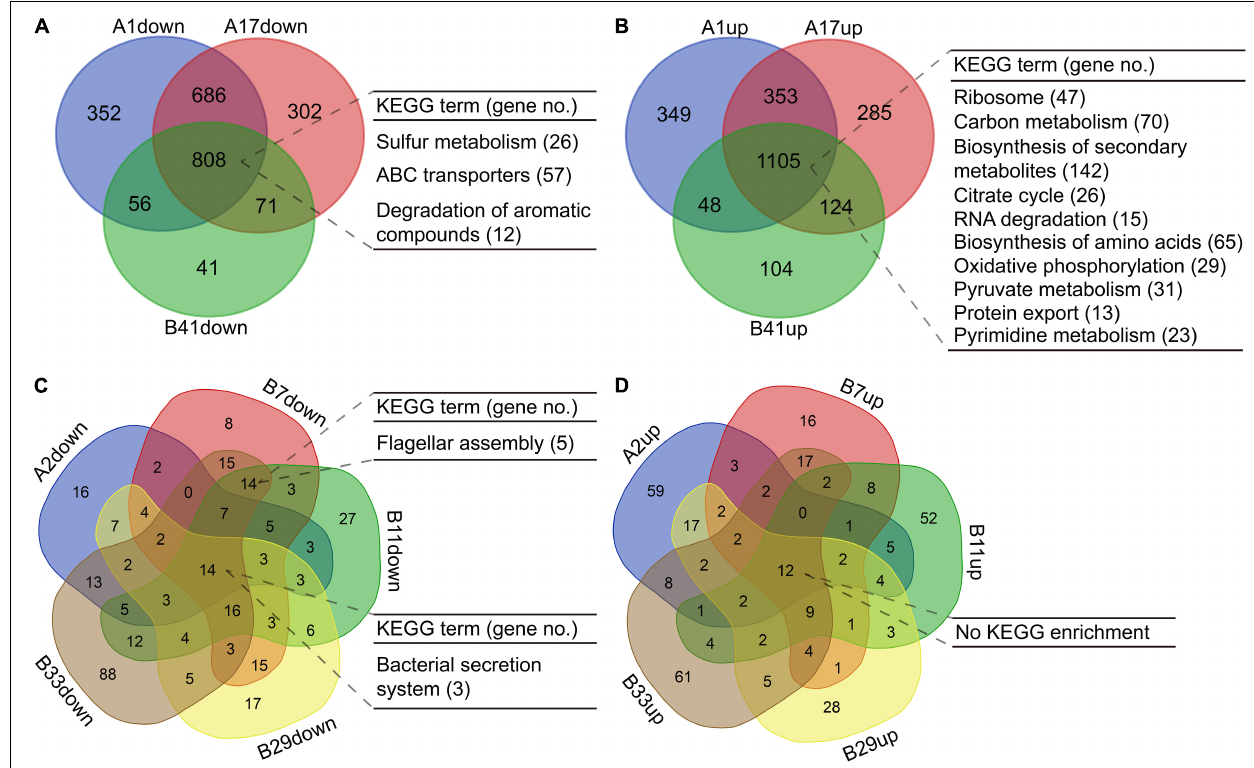
FIGURE 5 | Functional enrichment of differentially expressed genes in P. aeruginosa COPD isolates compared with PAO1. (A) Significantly enriched KEGG terms by the commonly down-regulated genes in P. aeruginosa isolates A1, A17, and B41. (B) Significantly enriched KEGG terms by the commonly up-regulated genes in P. aeruginosa isolates A1, A17, and B41. (C) Significantly enriched KEGG terms by the commonly downregulated genes in P. aeruginosa isolates A2, B7, B11, B29, and B33. (D) Significantly enriched KEGG terms by the commonly upregulated genes in P. aeruginosa isolates A2, B7, B11, B29, and B33. KEGG terms shown are p < 0.05, Benjamini < 0.05. All the differentially expressed genes used are p adj <